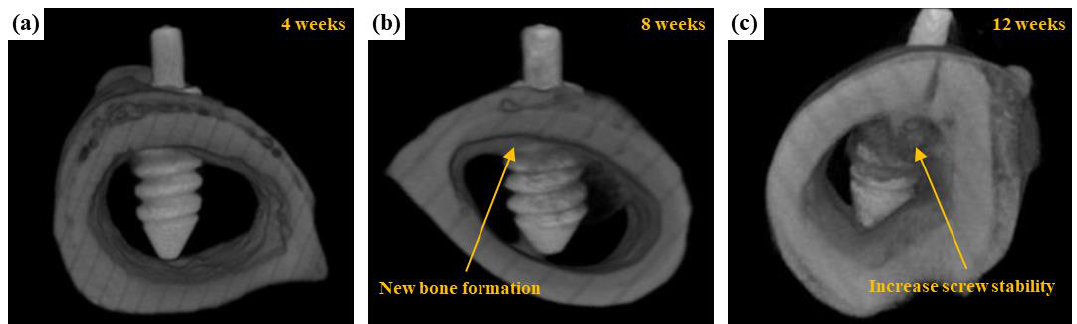
Figure 12. μCT reconstructed images showing the degradation processes of AZ31 bone-screw after implantation of ( a ) 4, ( b ) 8, and ( c ) 12 weeks.